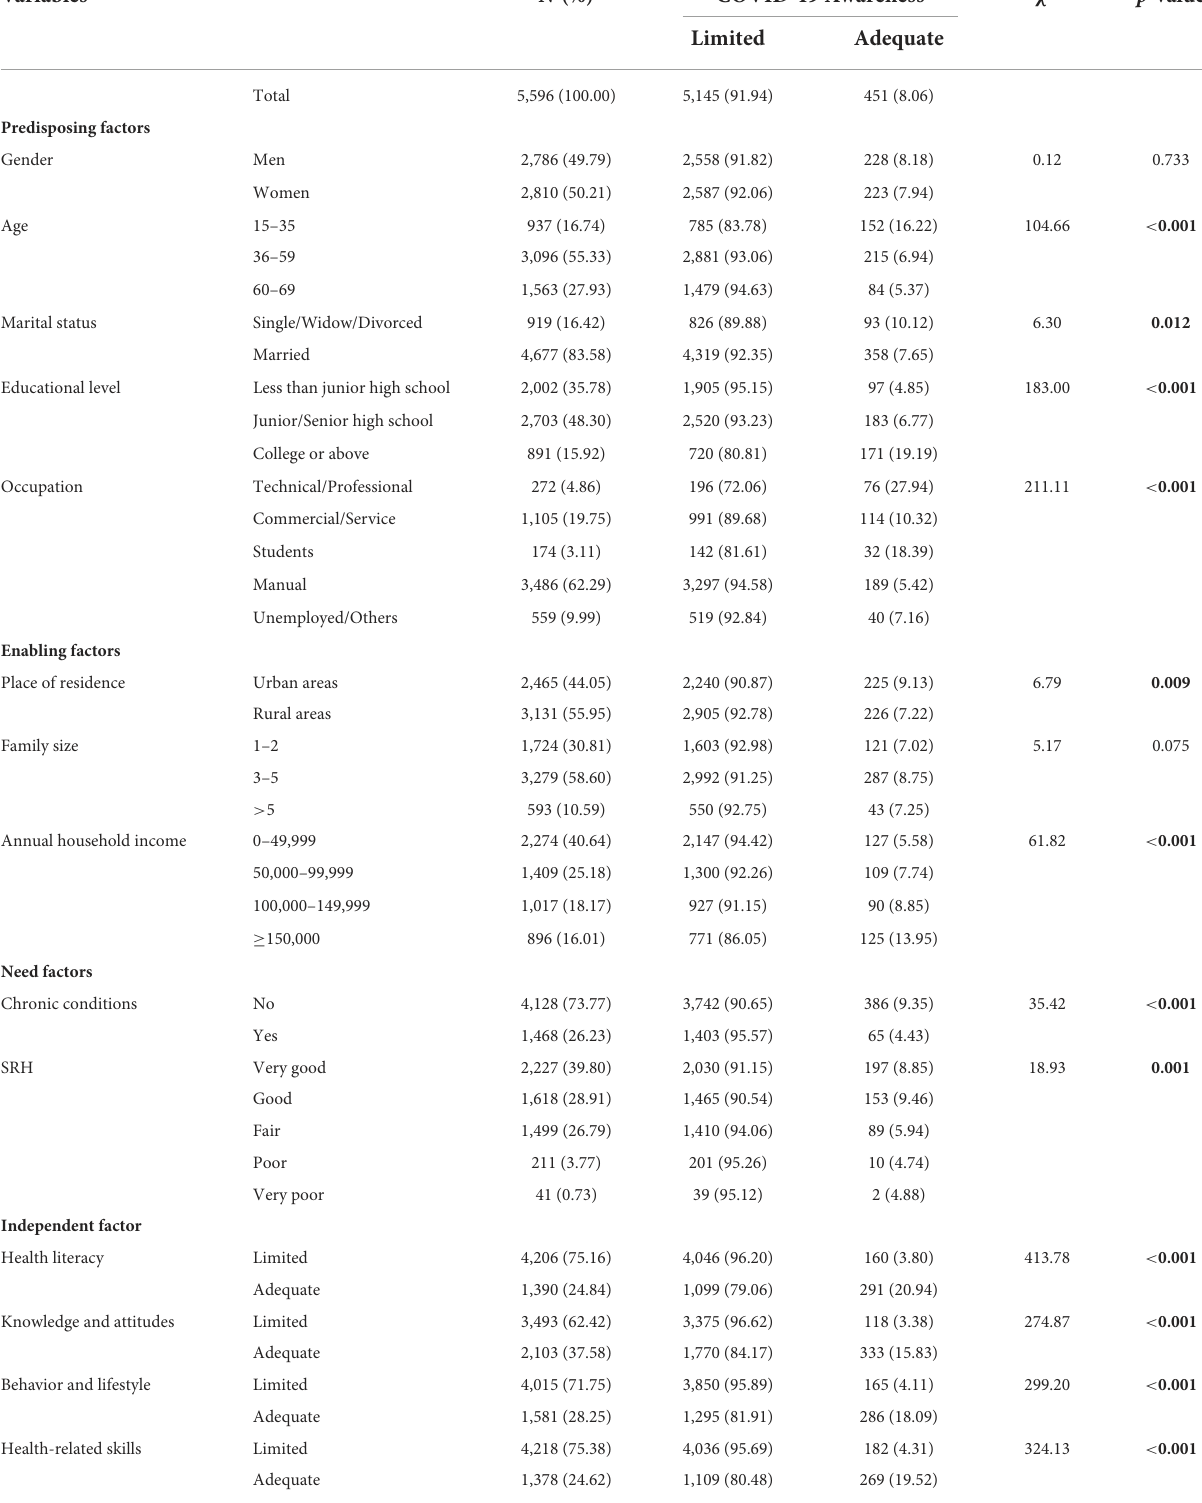
TABLE 2 The COVID-19 awareness level by participant